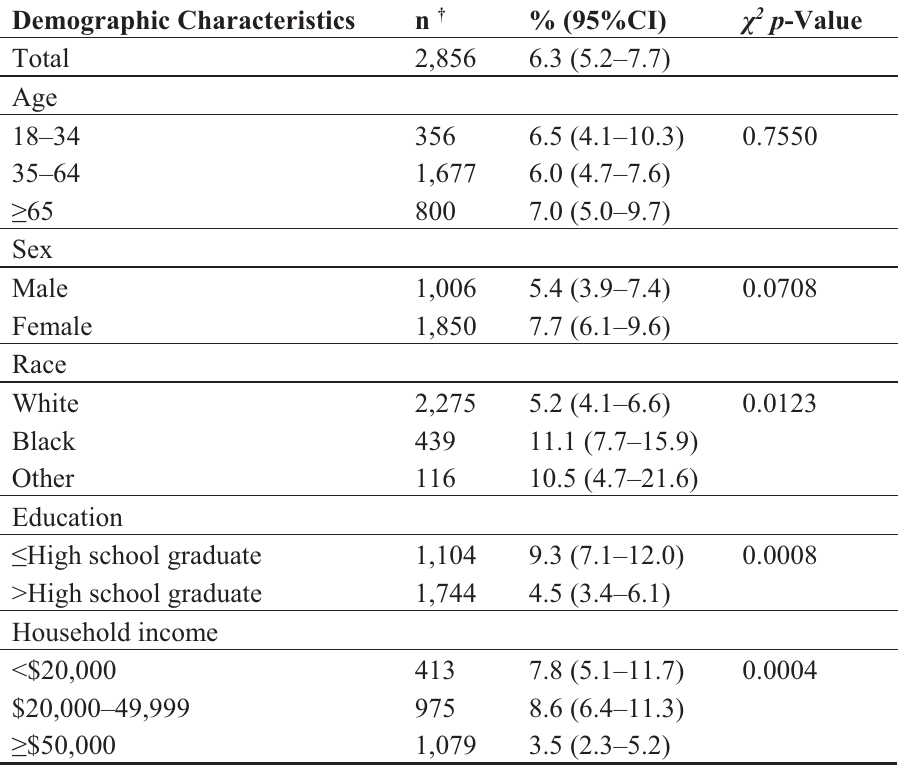
Table 1. Estimated proportion of Michigan adults who have a family history of sudden cardiac death of the young * by demographic characteristics, 2007 Michigan Behavioral Risk Factor Survey [19].